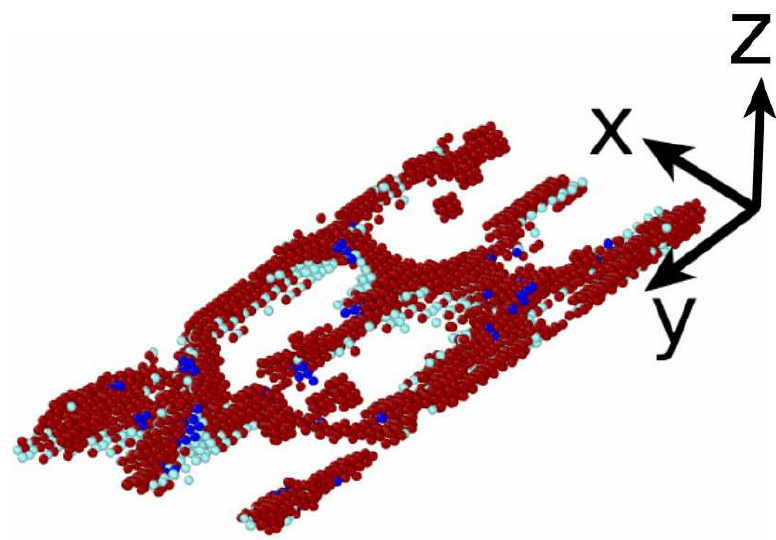
Figure 3. Perspective view—from the iron side—of the Bagaryatsky interface after the second conjugate-gradient minimization (cf. Figure 2b). To highlight the defect structure, all bcc and cementite atoms are deleted. Atoms are colored as in Figure